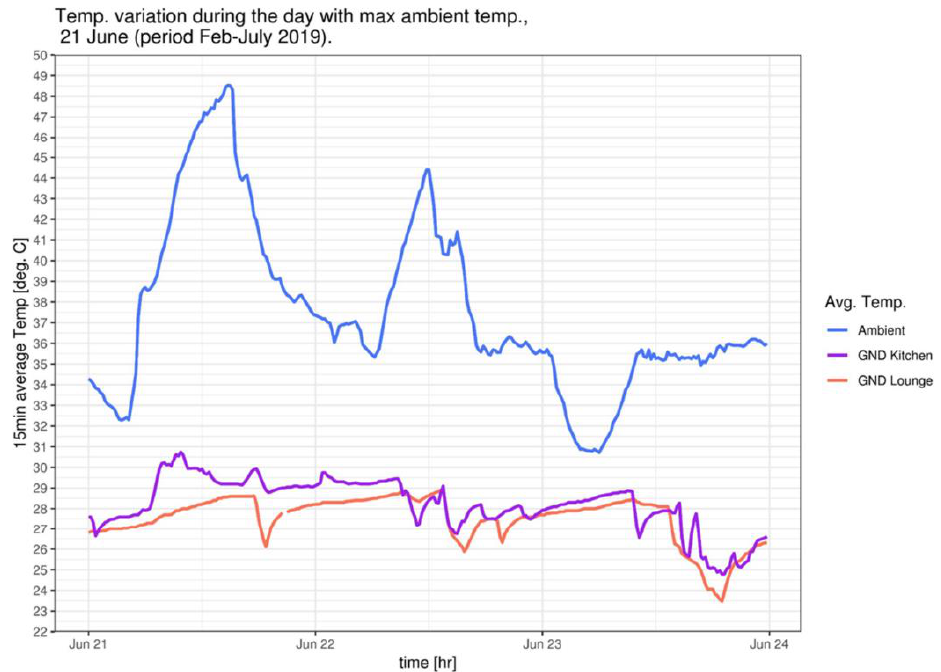
Figure 10. Temperature variation during the day with the maximum ambient temperature on 21 June 21 June 2019 in the measurement period from February to July 2019 in the measurement period from February to July 2019.